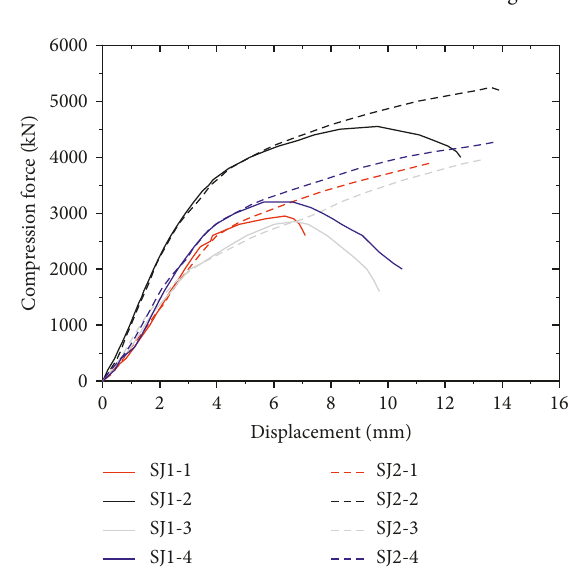
Figure 7: Load curves of the